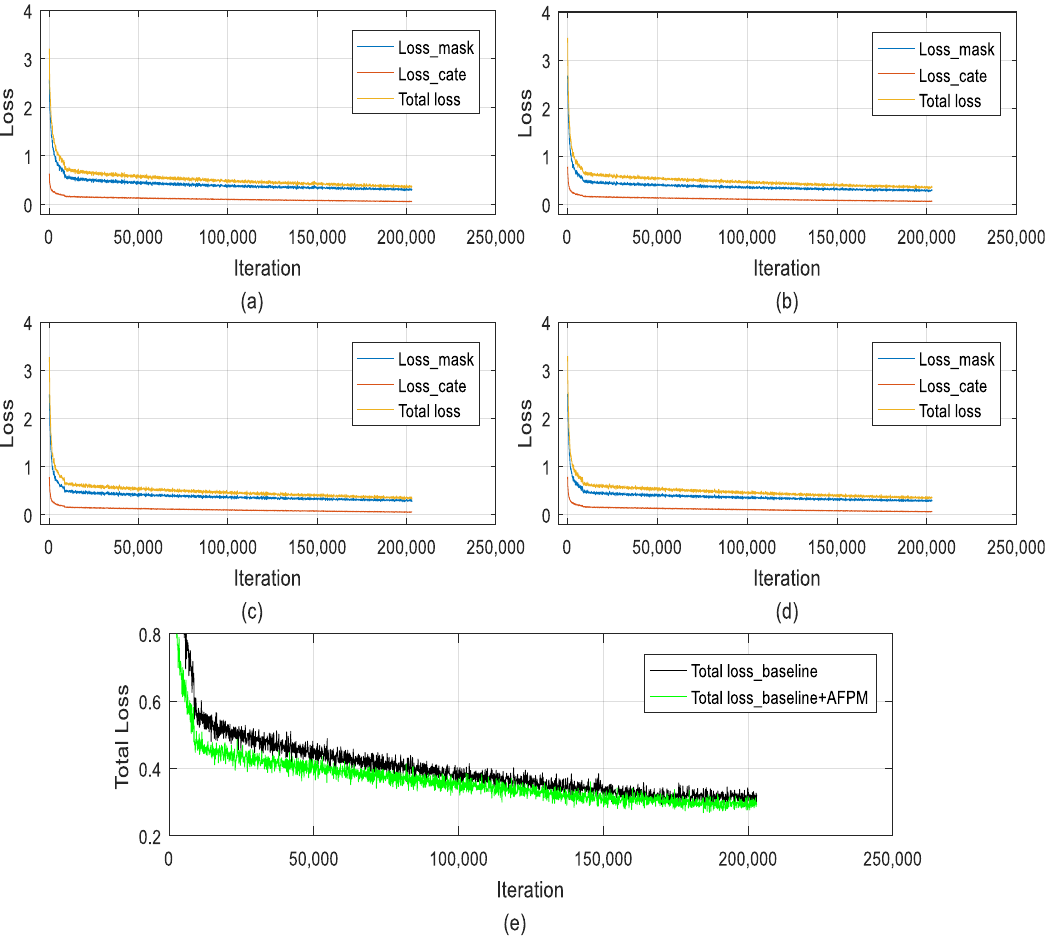
Figure 5. The loss function curve of different methods. ( a ) The loss curve of baseline; ( b ) the loss curve of baseline with CBAM; ( c ) the loss curve of baseline with CBAM and CTAM; ( d ) the loss curve of baseline with AFPM; ( e ) the total loss curve of baseline and baseline with AFPM.